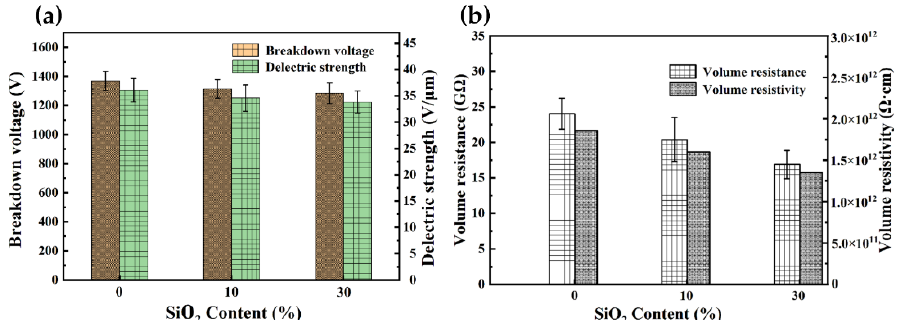
Figure 6. The voltage resistance ( a ) and electrical resistance properties ( b ) of various coatings.